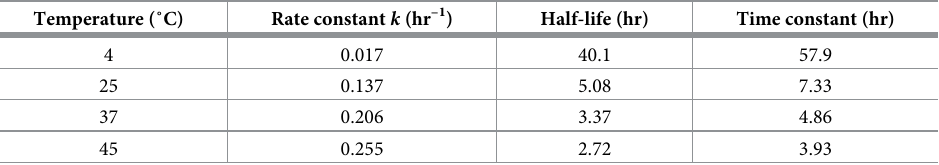
Table 2. Rate constants of RNA degradation reactions at various temperatures.